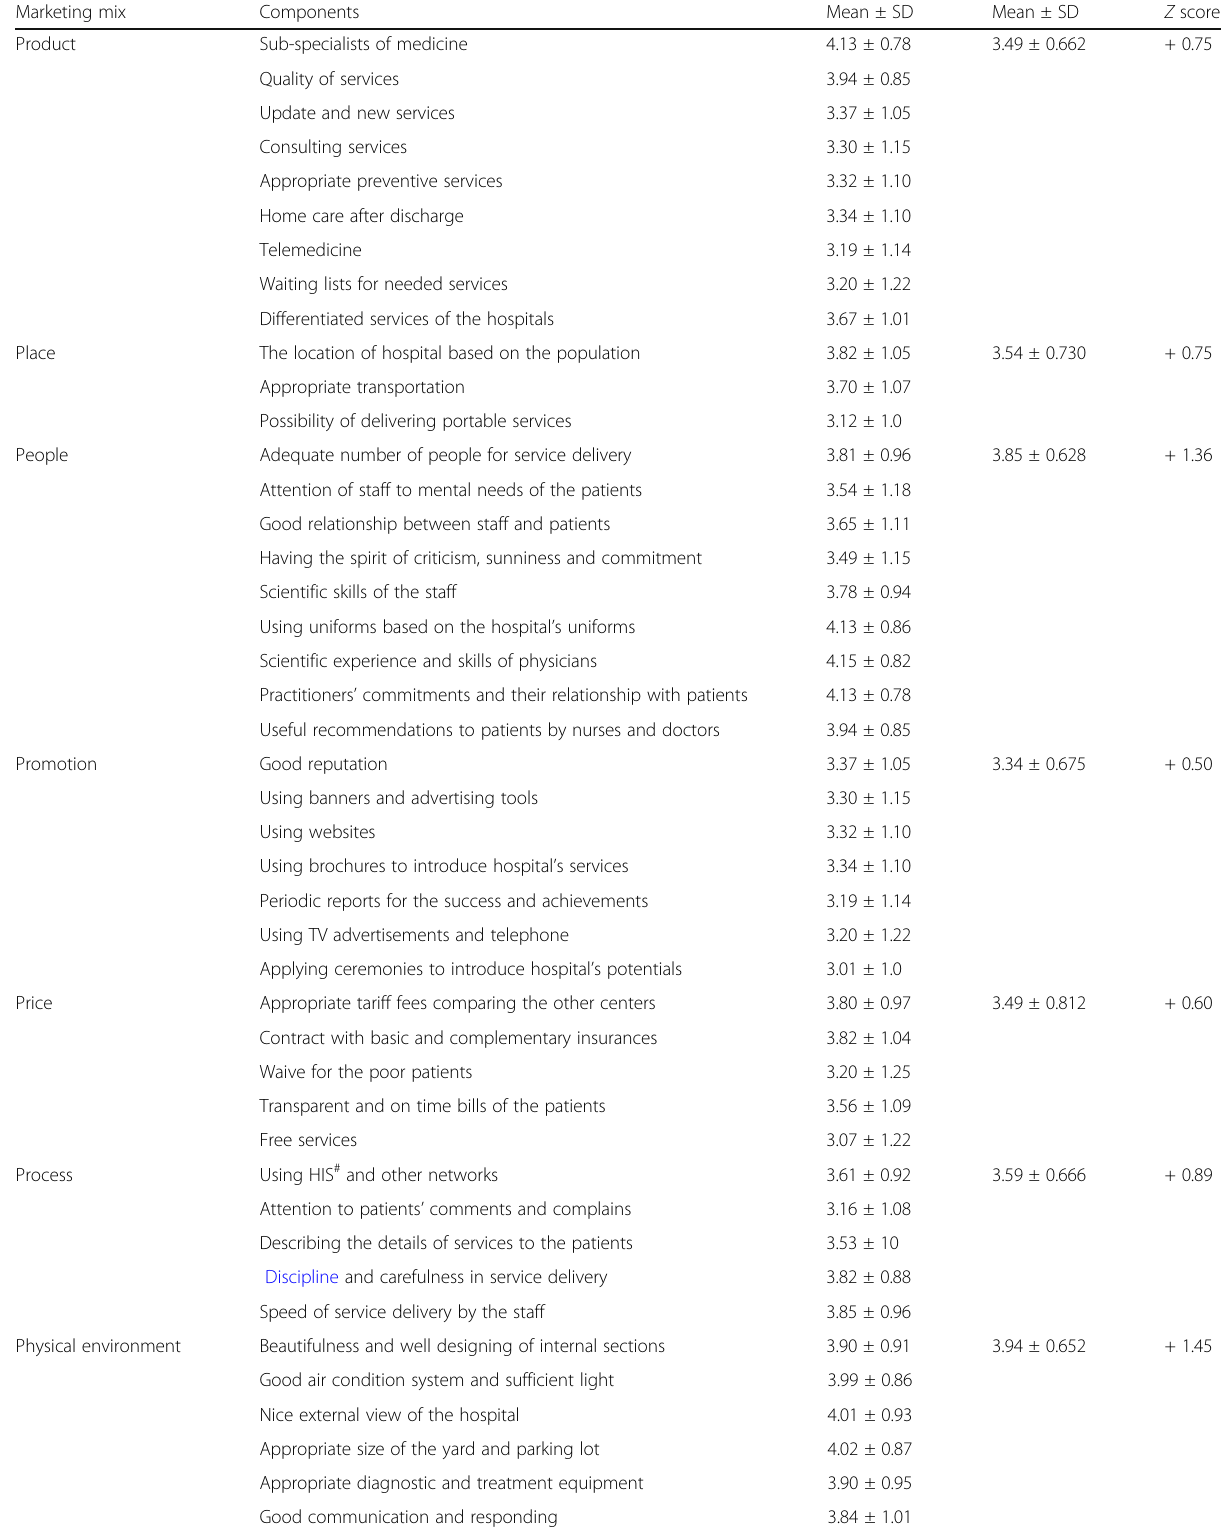
Table 2 Mean and standard deviation of marketing mix components Marketing